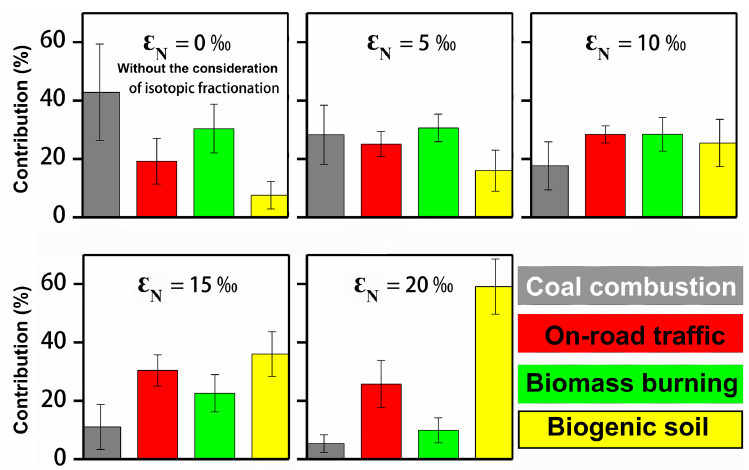
Figure 6. Estimates of the relative importance of single NO x sources (mean ± 1 σ ) throughout China based on the original δ 15 N–NO − values extracted from the literature ( ε N = 0‰) and under consideration of significant N isotope fractionation during NO x transformation ( ε N = 5‰, 10‰, 15‰ or